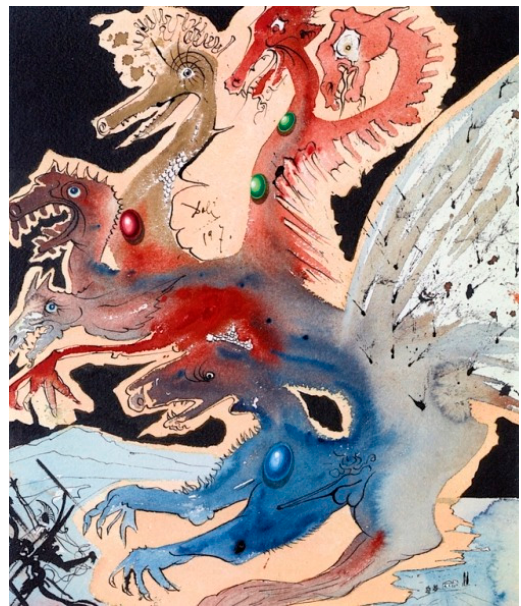
Figure 9. Scylla and Charybdis: Salvador Dali, 1970. There is always a price to pay, but it rests with us to set the limits.